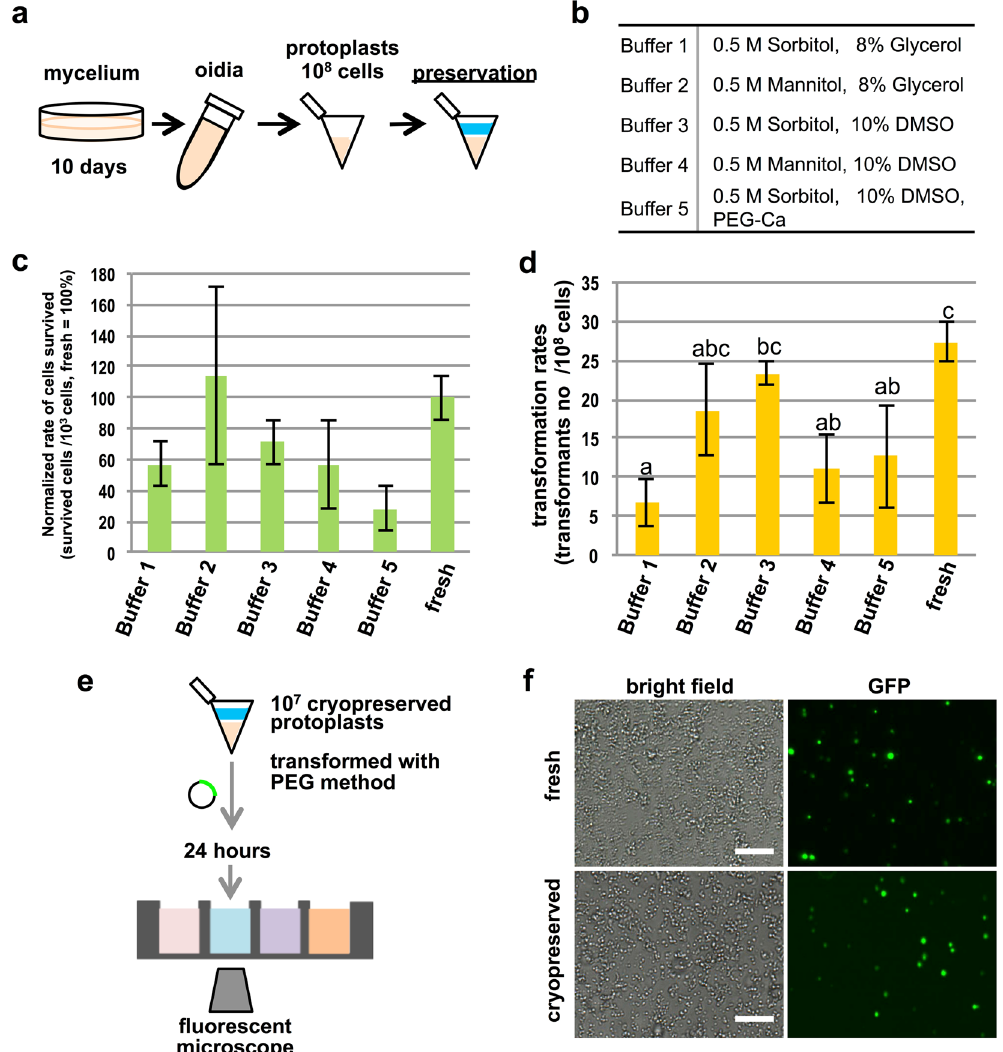
Figure 1. Cryopreservation of protoplasts of C. cinerea . Evaluation of protoplasts stored in different buffers at − 80 °C for 3 weeks. ( a ) Schematic image of the protoplast preservation experiments. ( b ) The buffers used for cryopreservation of protoplasts. ( c ) Survival rates defined by the number of surviving cells per 10 3 preserved cells. Survival rate of fresh protoplasts was defined as 100%. ( d ) Transformation rates defined by the number of hygromycin-B resistant colonies in 10 8 preserved cells. Error bars in ( b ) and ( c ) show S.D. n = 3; bar plots with the same lower case characters were statistically significant groups as tested by Turkey’s HSD test ( P < 0.05). ( e ) Schematic image of the transient expression assay using preserved protoplasts which were stored at − 80 °C with buffer 3 for three weeks. ( f ) Fluorescent images of protoplasts 24 hrs after transformation. Fresh and cryopreserved protoplasts were compared. Scale bar: 50 µ